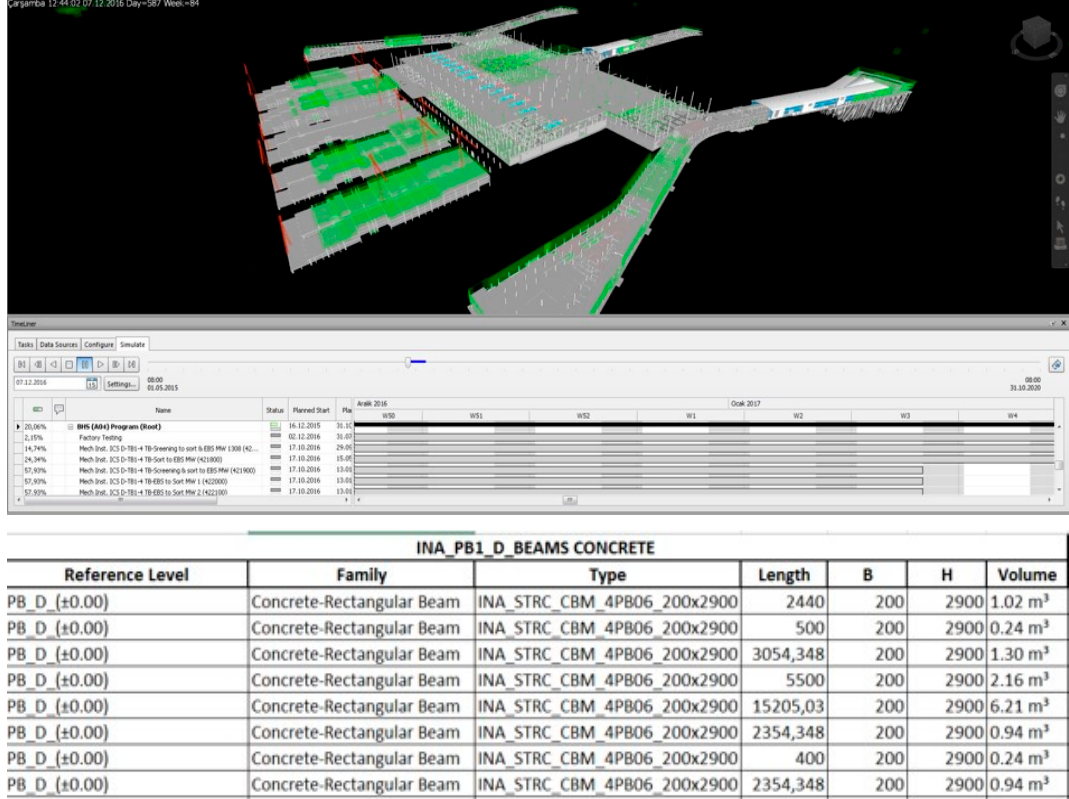
Figure 8. 4D Simulation view of the architectural and structural master BIM